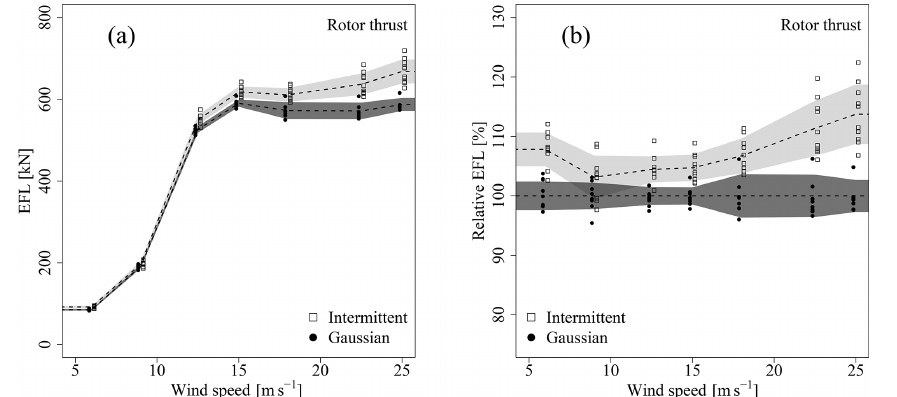
Figure 7. EFL (see Eq. 4) for the rotor thrust for all realizations and all wind speeds for the fully correlated case. The data points were shifted horizontally for a better distinction between intermittent and Gaussian data. The dashed lines represent averages; the shaded area covers ± 1 standard deviation around the average. (a) Standard representation. (b) Data are normalized with the average of the Gaussian result (Gaussian averages correspond to 100%).